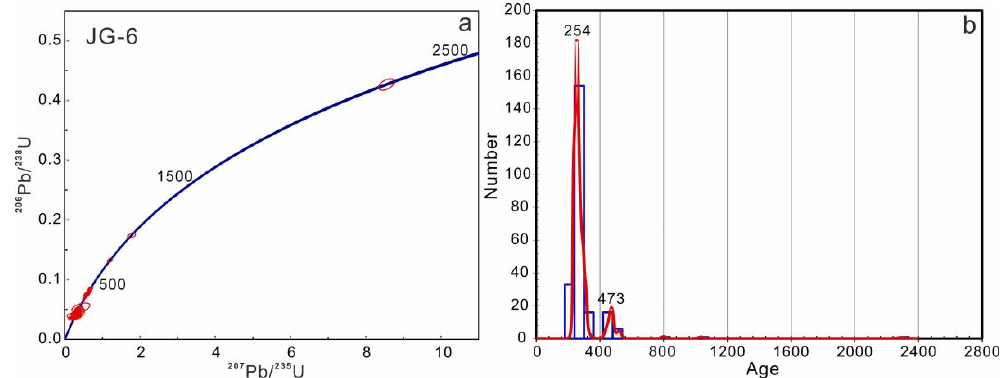
Figure 5. Representative CL images of zircon from the ( a ) conglomerate and ( b – d ) granitic pebbles in the conglomerate. The solid-line and dash-line circles represent the locations for U-Pb dating and in situ Lu-Hf isotope analysis, respectively. The numbers show the ages of the zircons (Ma) and the ε Hf (t) values.